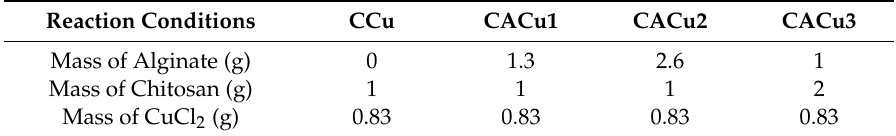
Table 2. Mass of reactants used in the preparation of binary and ternary composite